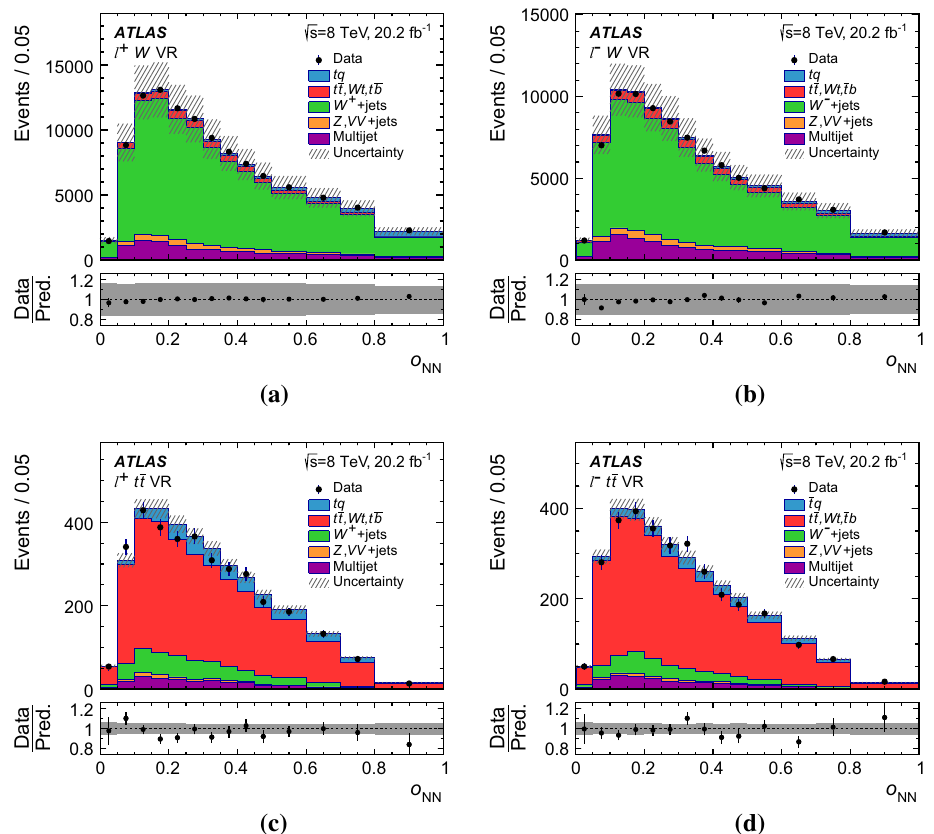
Fig. 5 Observed O NN distributions ( a , b ) in the W +jets VR and ( c , d ) in the t ¯ t VR compared to the model obtained from simulated events. The simulated distributions are normalised to the event rates obtained by the fits of the E miss distributions as described in Sect. 6. The hatched T